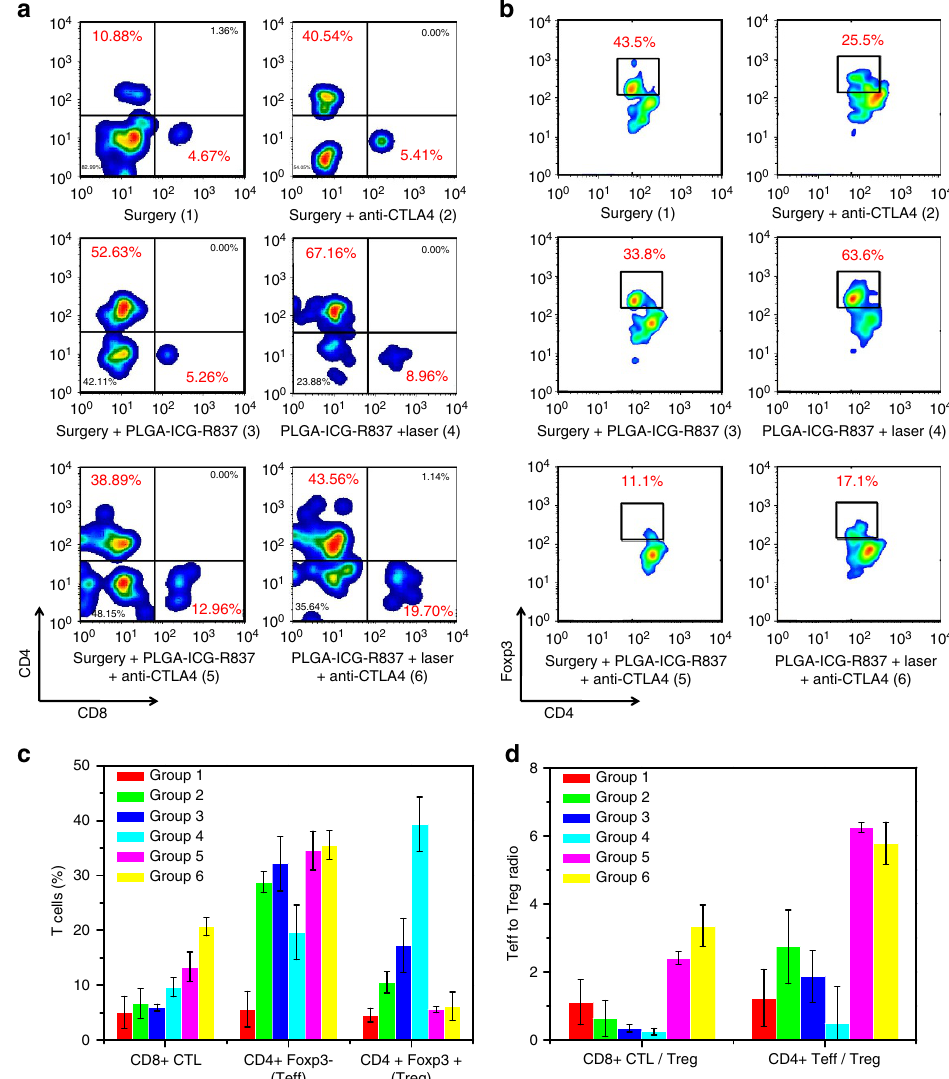
Figure 4 | The mechanism study. ( a ) Representative flow cytometry plots showing different groups of T cells in secondary tumours. Tumour cell suspensions were analysed by flow cytometry for T-cell infiltration (gated on CD3 þ Tcells). ( b ) Representative flow cytometry plots showing percentages (gated on CD4 þ cells) of CD4 þ FoxP3 þ T cells in secondary tumours after various treatments indicated. ( c ) Proportions of tumour-infiltrating CD8 þ killer T cells, CD4 þ FoxP3- effector Tcells and CD4 þ FoxP3 þ regulatory Tcells according to data in a and b . ( d ) CD8 þ CTL: Treg ratios and CD4 þ effector Tcells: Treg ratios in the secondary tumours upon various treatments to remove the first tumours. Both ratios were significantly enhanced after combination treatment with PLGA-ICG-R837-based PTTand anti-CTLA4 therapy. Three mice were measured in each group in a – d . Data are presented as the mean ± s.e.m. Error bars are based on triplicated